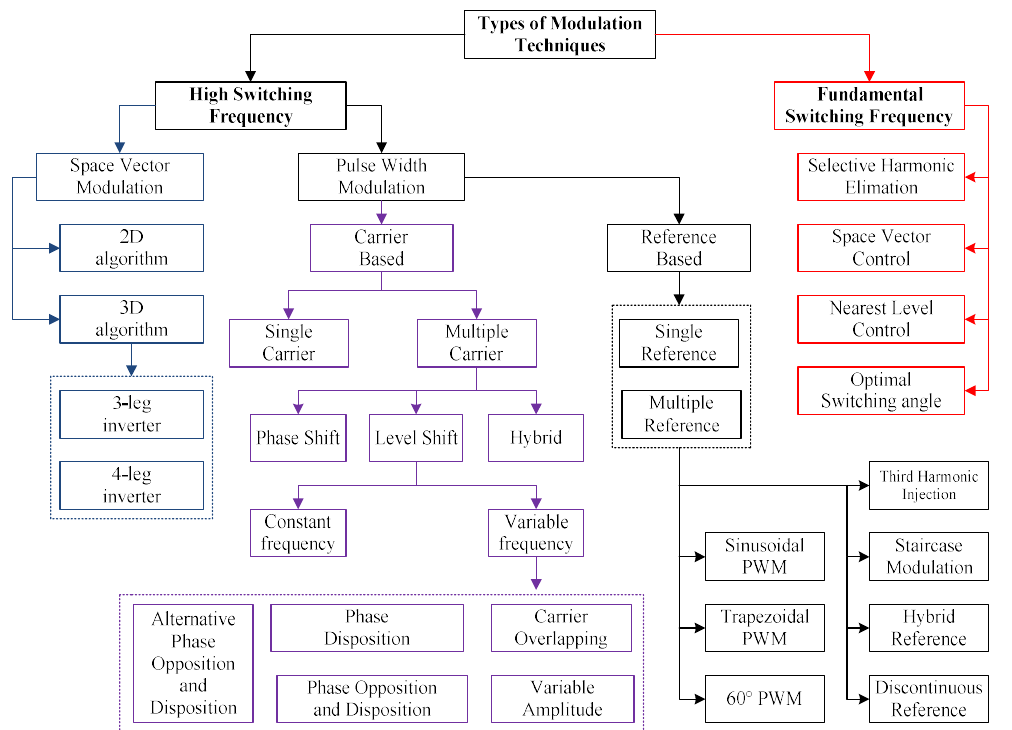
Figure 7. Taxonomy tree of different modulation techniques.